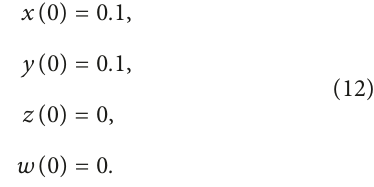
Figure 1. The complex dynamic behaviors of Experiment 2 are shown in Figures 11–13.